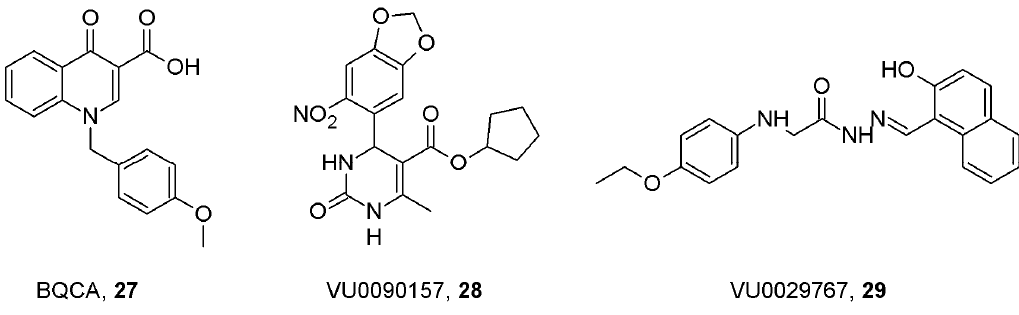
selective allosteric 1